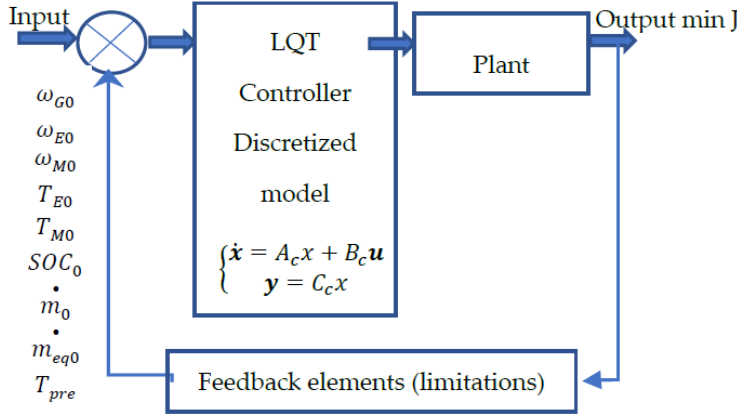
Figure 3. Architecture of the linear quadratic tracking (LQT) algorithm.